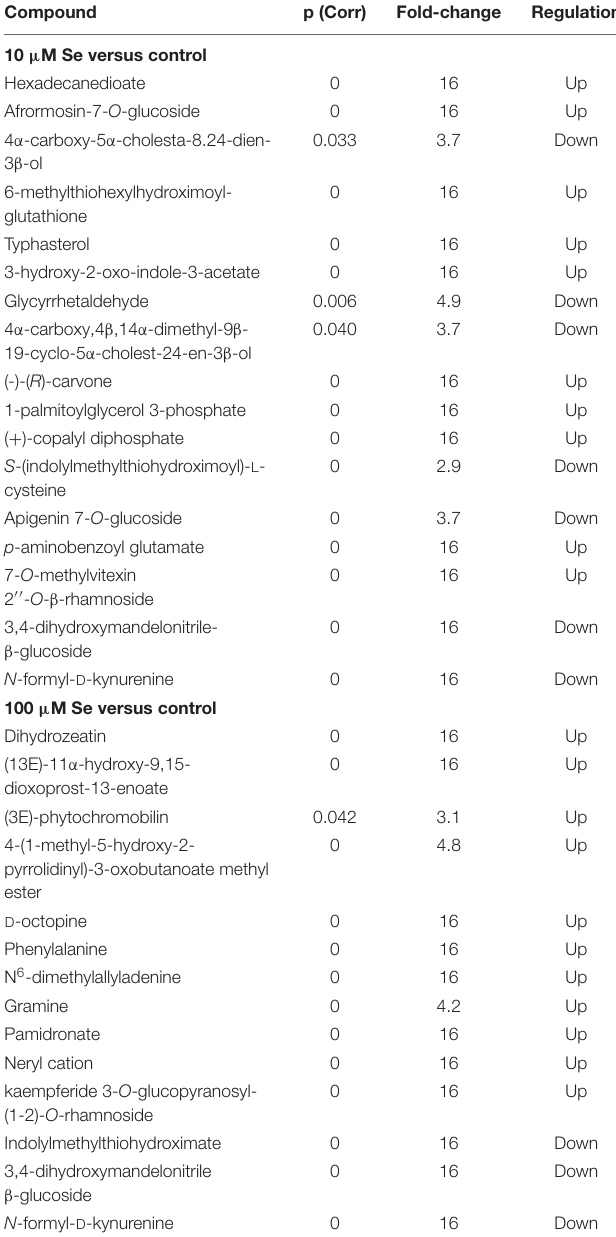
TABLE 4 | Volcano analysis (moderated t -test, p ≤ 0.05, fold change cut off = 2) of strawberry metabolites identified using the database PlantCyc.